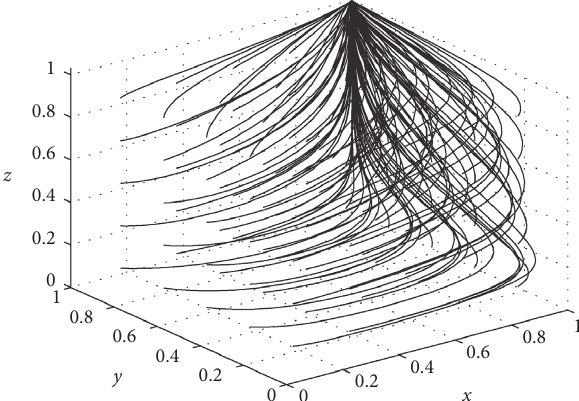
Figure 4: Dynamic evolution of three parts’ decision-making.